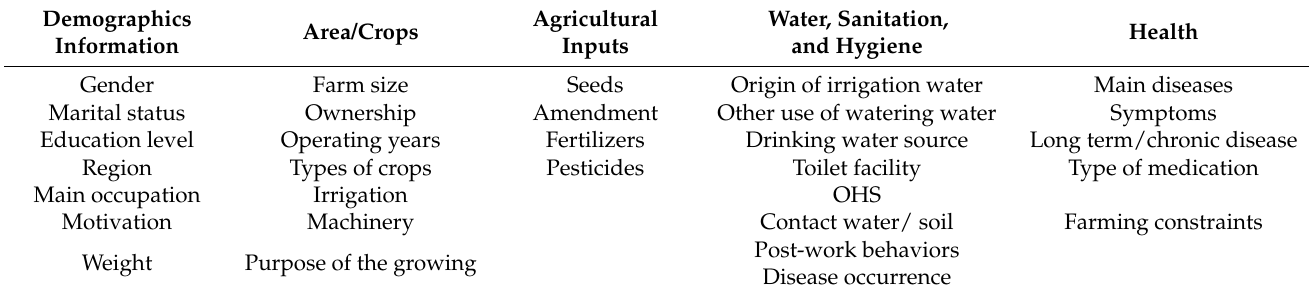
Table A1. Key information and different components of farmers’